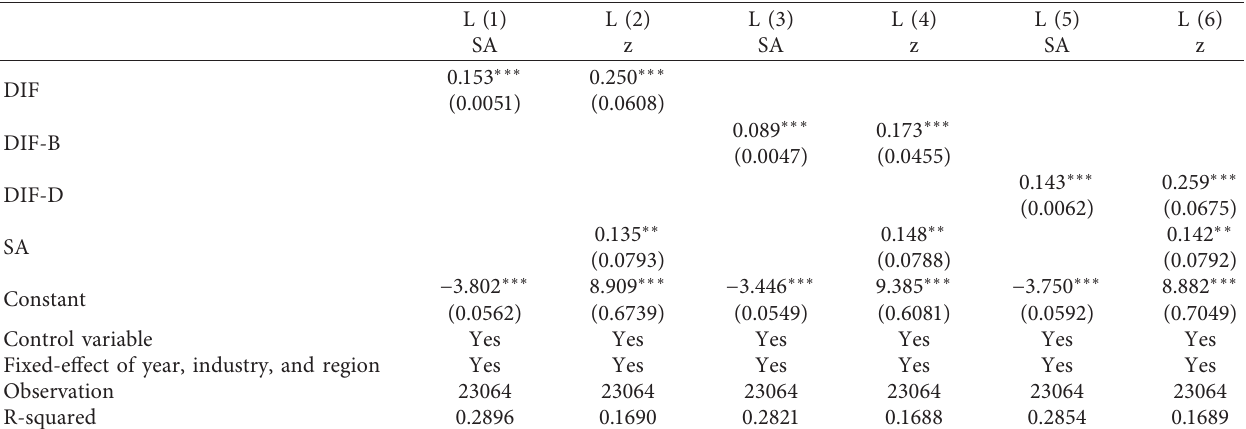
Table 5: Mechanism analysis.